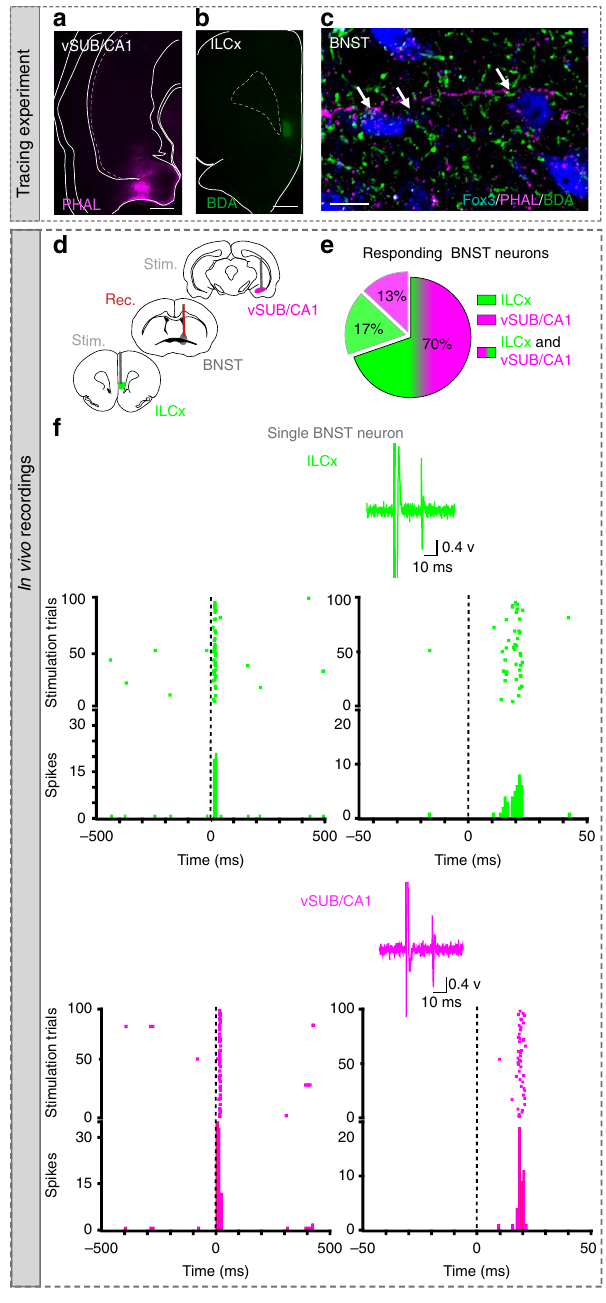
Figure 1 | Characterization of vSUB/CA1-ILCx-amBNST pathways. ( a , b ) Injection sites: anterograde tracers (PHAL, BDA) were respectively injected in the vSUB/CA1 ( a , magenta) and the ILCx ( b , green). Scale, 0.5mm. ( c ) Immunofluorescence confocal images showing strong convergences (white arrows) of vSUB/CA1 (magenta) and ILCx (green) terminals, on amBNST neuron (Fox3 labelling, blue). Scale bar, 10 m m. ( d ) Experimental protocol. ( e ) Percentage of amBNSTneurons responding to the stimulation of the ILCx, vSUB/CA1 or both. ( f ) Typical PSTHs ( þ raster) showing respective excitatory responses of a same amBNSTneuron to ILCx (top) and vSUB/CA1 (bottom) stimulation. Stimulus: t0 (gray lines). PSTH with 500ms scale and Bin width, 5ms (left) and PSTH of the same neuron with 50ms scale and bin width, 1ms on the right. Insets: representative